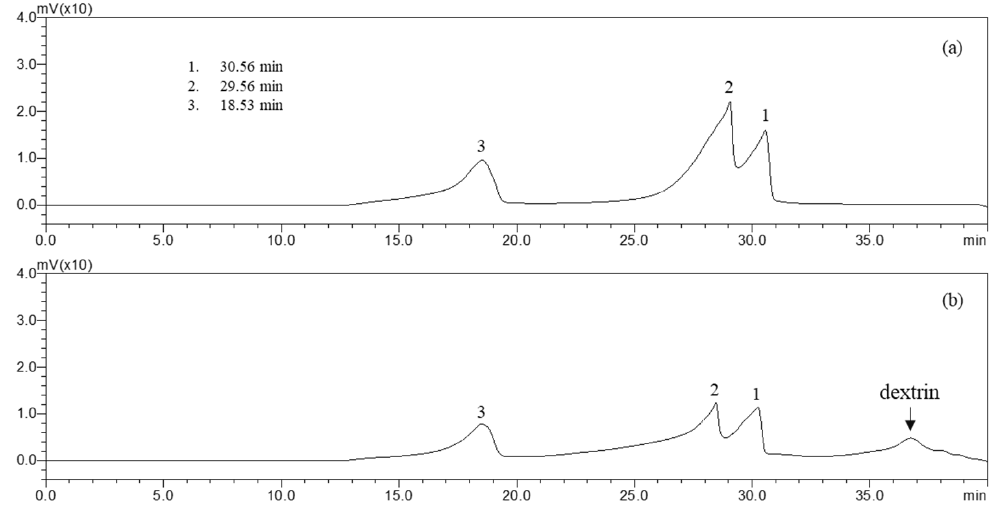
Figure 2 . GPC chromatogram of molecular weight. Peak in ( a ) SH hot-water extract and ( b ) SH hot-water extract after spray drying (dextrin added).